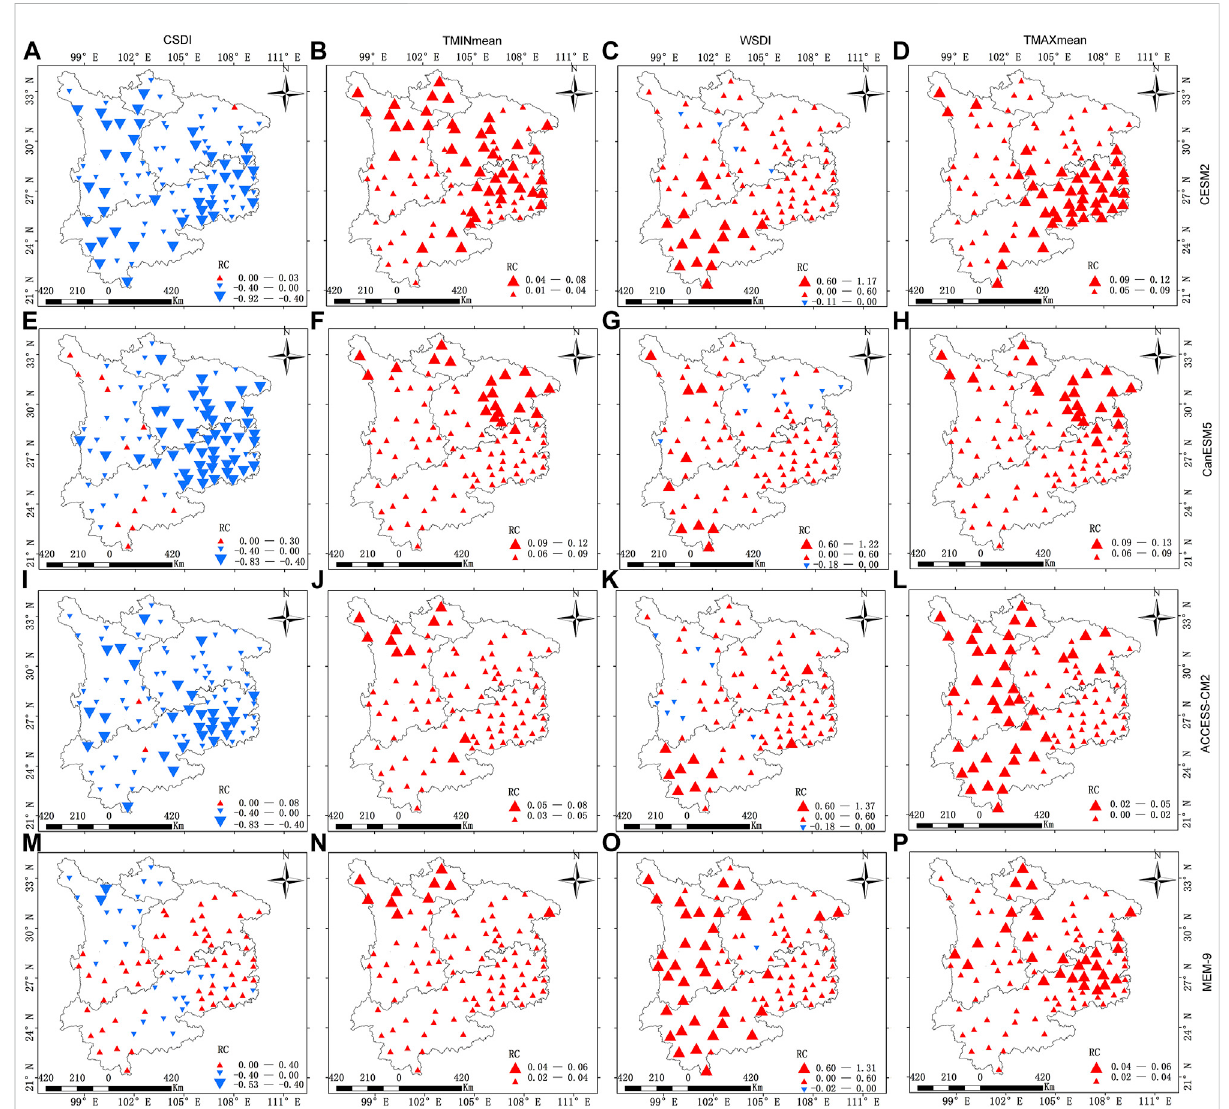
FIGURE 4 Projections of spatial change trends of the 4 ETIs in the next 20 years obtained using different models under the SSP2-4.5 scenario. CESM2 [ (A) CSDI (B) TMINmean (C) WSDI (D) TMAXmean], CanESM5[ (E) CSDI (F) TMINmean (G) WSDI (H) TMAXmean],ACCESS-CM2 [ (I) CSDI (J) TMINmean